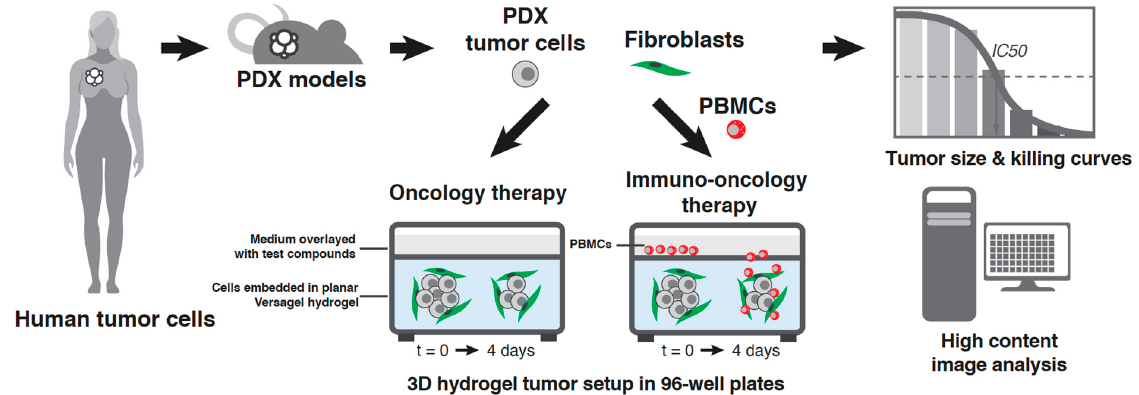
Figure 1. Three-dimensional VersaGel Tumor Model Process: Schematic of the 3D tumor model setup process. First, patient cells are grown in PDX, followed by their establishment into cell lines with limited passages. The PDX-derived cell lines are mixed with human dermal fibroblasts (HDF) and embedded in the VersaGel hydrogel in 96-well plates. Several days later, drug compound and PBMCs are added to the assays, followed by endpoint analysis on day 4 using high-content imaging to analyzing tumor size and killing.